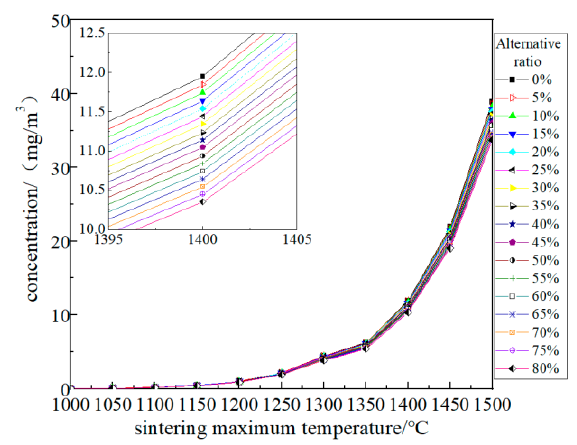
Figure 10. Change of CO emission concentration in the case of straw charcoal